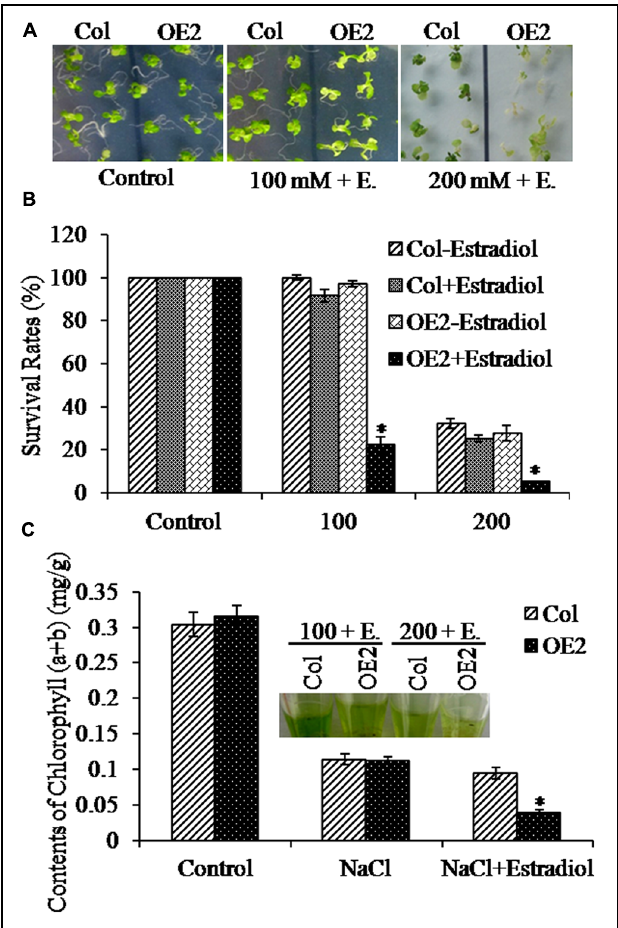
FIGURE 3 | Analyses of salt stress responses in OE2 plants. Asterisk symbols ( ∗ ) indicate p < 0.05 (Student t- test). (A) Phenotypes of 15-day-old plants of Col and OE2 on MS plates containing NaCl (100 and 200 mM, respectively). The 5-day-old seedlings grown on MS plates were transferred into the corresponding NaCl-containing plates. Photos were taken after 10 days of treatments. Estradiol: 17- β -estradiol (10 μ M). (B) The survival rates of Col and OE2 plants were measured after treated with NaCl (100 and 200 mM, respectively). The data are means ± SE of three independent experiments ( n > 15 for each repeat). (C) The chlorophyll contents of Col and OE2 plants were measured after treated with NaCl (100 mM) with or without estradiol induction. The data are means ± SE of three independent experiments ( n > 15 for each repeat).